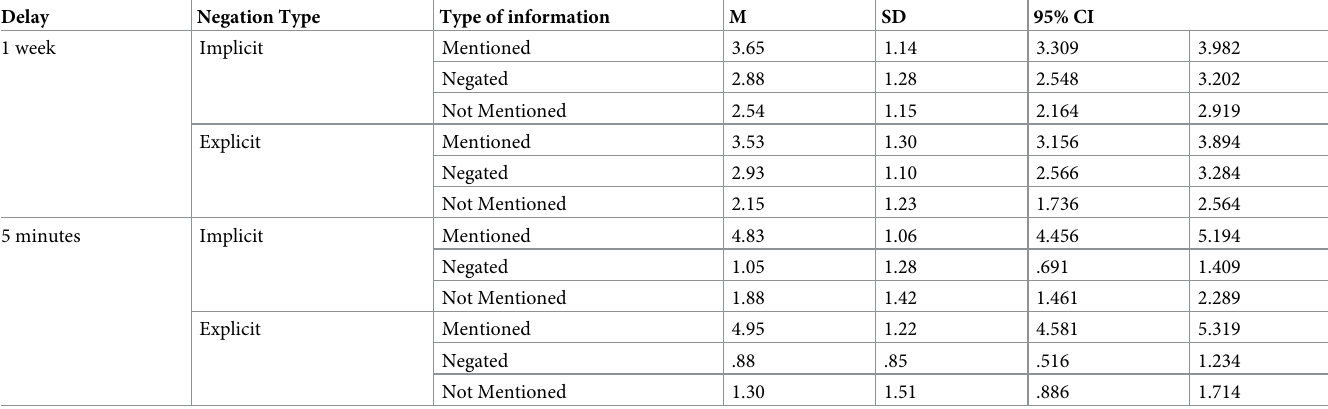
Table 1. Expected marginal means for ‘Present’ answers across information types and treatments.